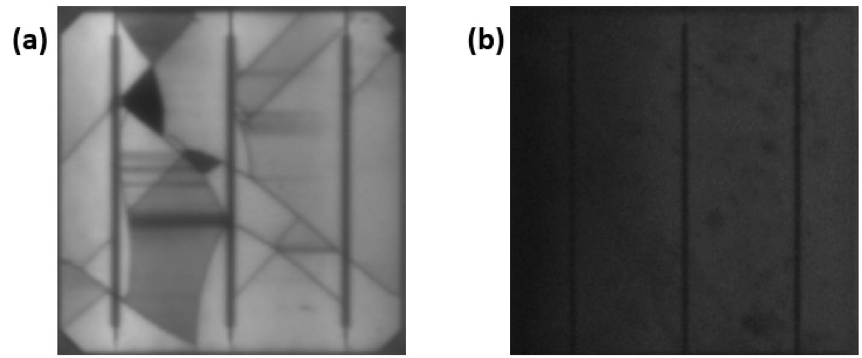
Figure 1. EL image of solar cells ( a ) Affected by cracks and structural defects, ( b ) affected by PID.